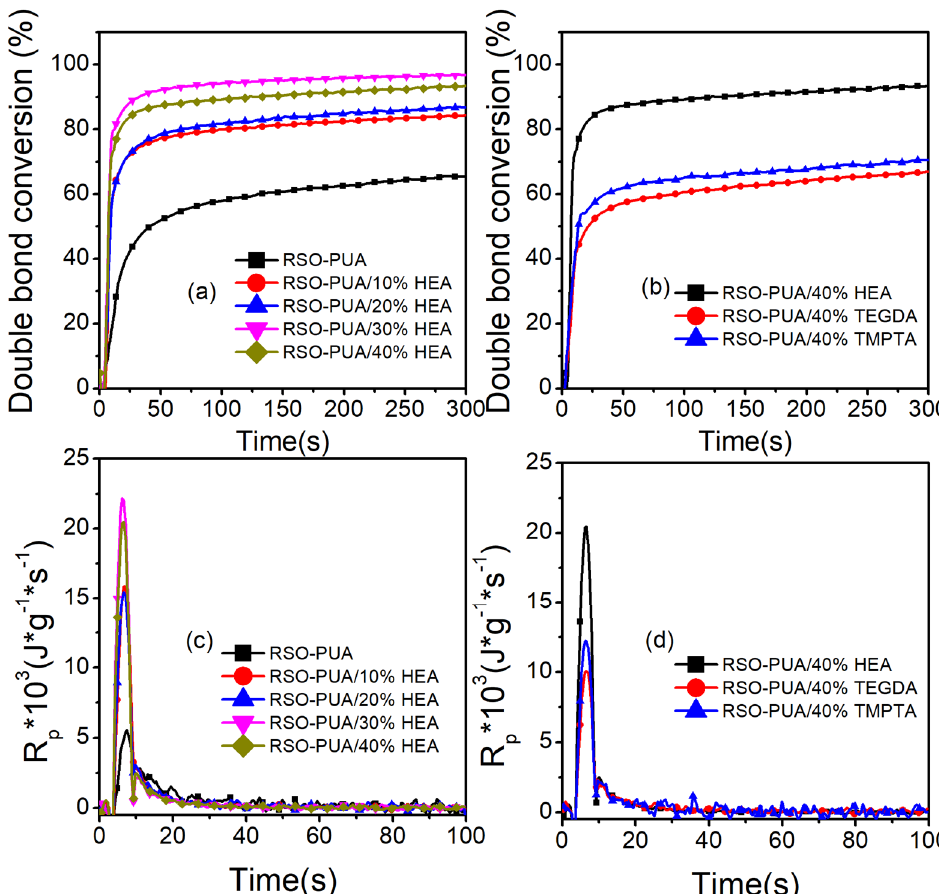
Figure 6. ( a , b ) Double bond conversions and ( c , d ) polymerization rate of the RSO-PUA resins.